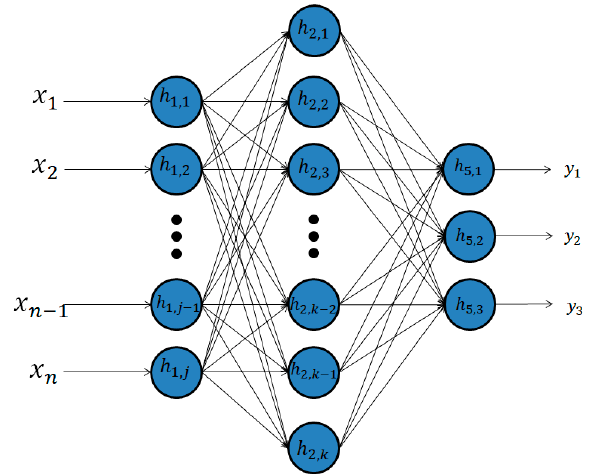
Figure 1. Shallow neural network.